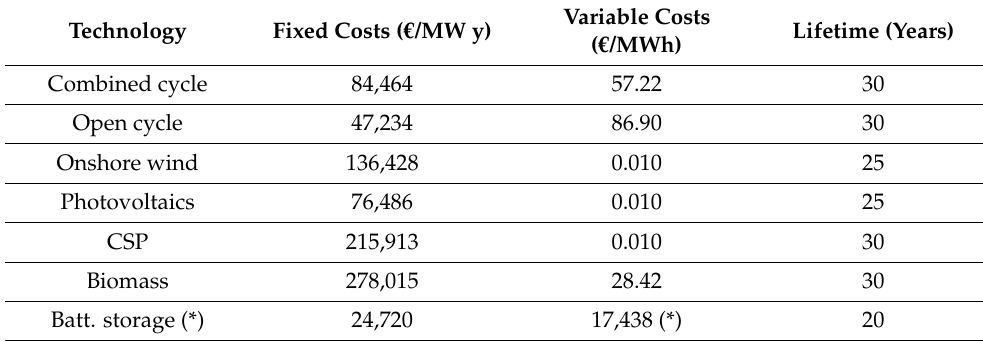
Table 3. Cost hypothesis. Carbon price equal to 35 € /tCO 2 . Data from References [6,11,39,40]. Variable Costs Lifetime (Years) Technology Fixed Costs ( € /MW y) ( € /MWh) Combined cycle 84,464 57.22 30 Open cycle 47,234 86.90 30 Onshore wind 136,428 0.010 25 Photovoltaics 76,486 0.010